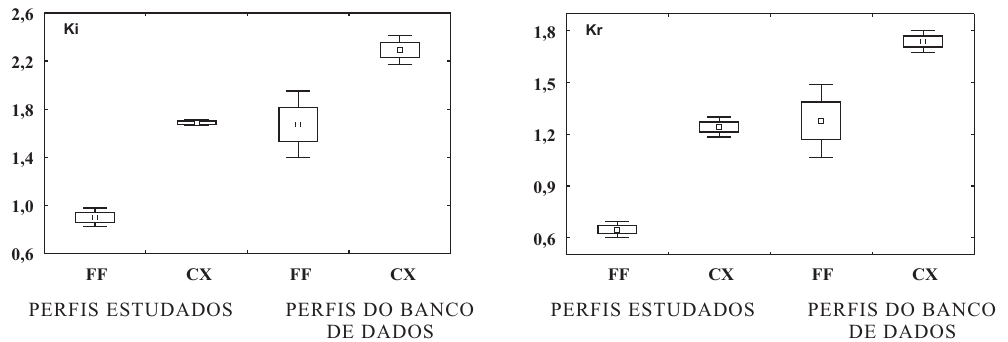
Figura 2. Médias, erro-padrão (box) e intervalo de confiança (erro-padrão . 1,96) das relações Ki e Kr de amostras de Plintossolo Pétrico (FF) e de Cambissolo Háplico (CX) estudadas e recuperadas de diversas fontes (Jacomine, 1969; Brasil, 1981, 1982; Embrapa, 1983; Camargo et al., 1988; Carvalho Filho et al., 1993; Jacomine et al.,